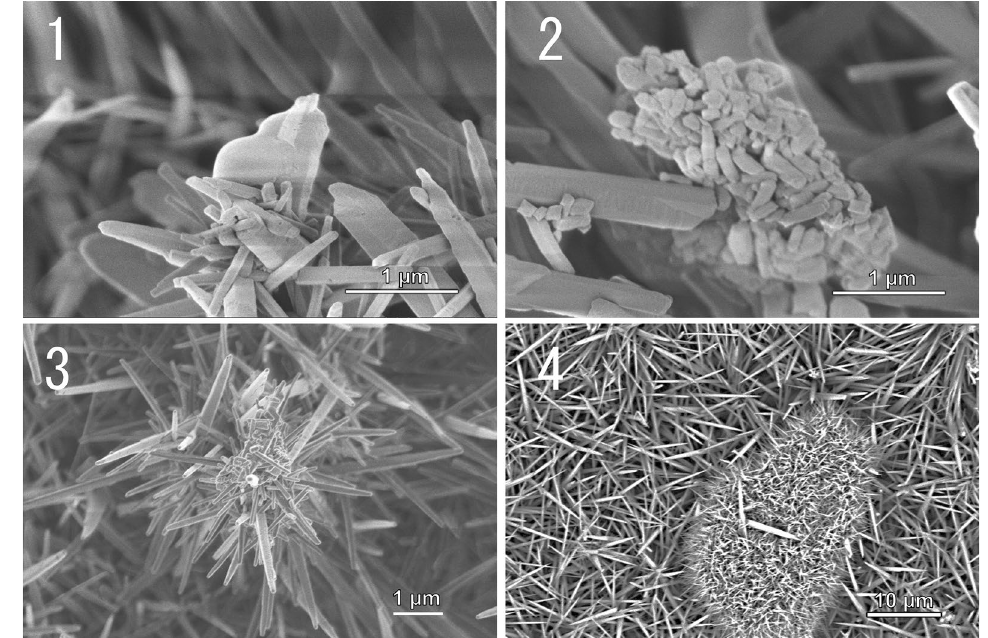
Figure 7. The SEM image of acicular aragonite-modified TiO 2 ceramic surface after 3 weeks of exposure to circulating mineral water containing E. coli . A cell membrane fragment of a dead cell is observed and aragonite crystals have started to grow on its surface (1). Aragonite crystals start to grow and cover the surfaces of dead cells (2). The growth of aragonite crystals is stimulated by the circulating mineral water, resulting in the large acicular crystals observed (3). A cluster of dead bacterial cells covered by acicular aragonite (4).